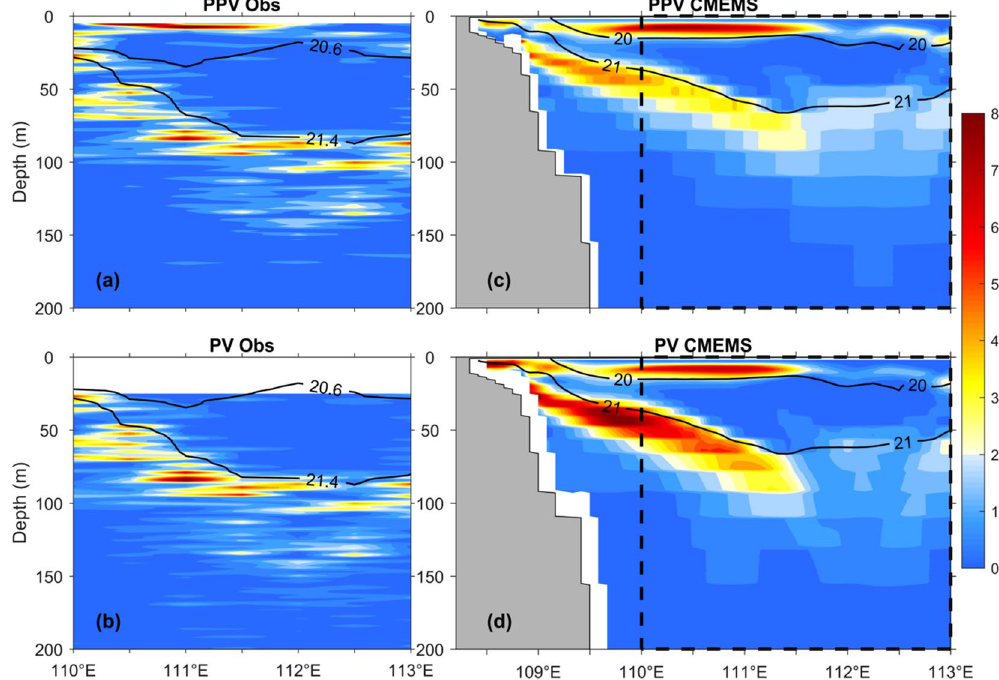
Figure 3. Potential vorticity (PV; × 10 − 9 m − 1 s − 1 ) along transect E based on observations and CMEMS reanalysis. Top: Planetary PV (PPV). Bottom: absolute PV. PV values are color coded. Isopycnals (black contours) bound the lens-shaped structure (20.6 σ θ and 21.4 σ θ for observations as Fig. 2i; 20 σ θ and 21 σ θ for reanalysis as Fig. 4i). The in situ velocities are only available below 24.7 m, and hence the blank area is shown above ~25 m in ( b ). The dashed boxes (right column) represent the area where observed data were collected. The figure is generated using Matlab R2011a